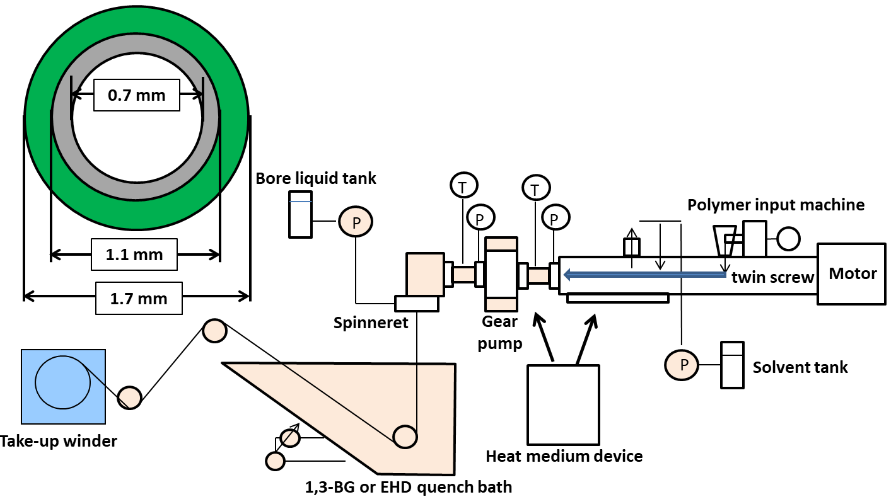
Figure 2. Schematic of the twin-screw kneader for hollow fiber membranes via the